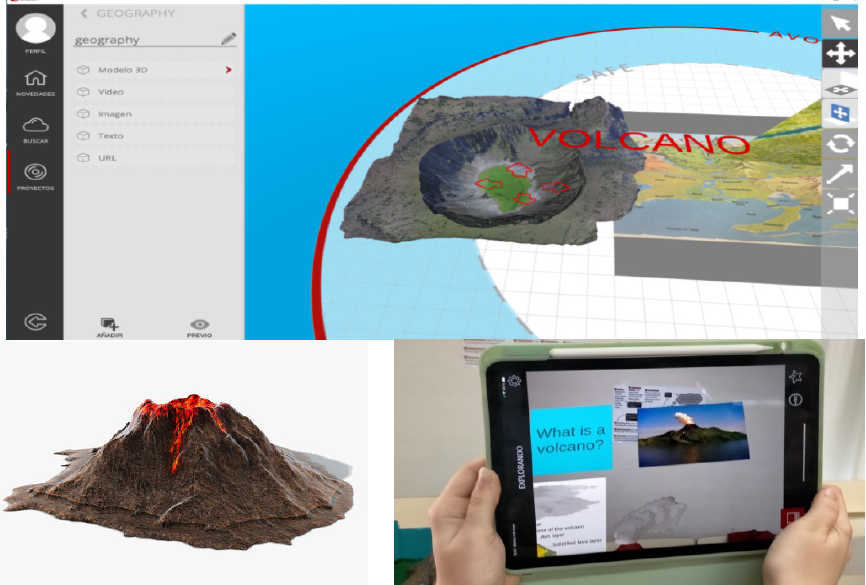
Figure 2. AR project (from top to bottom: Aumentaty Creator software, 3d Model of a volcano used as a trigger, image scan of the volcano by participants).